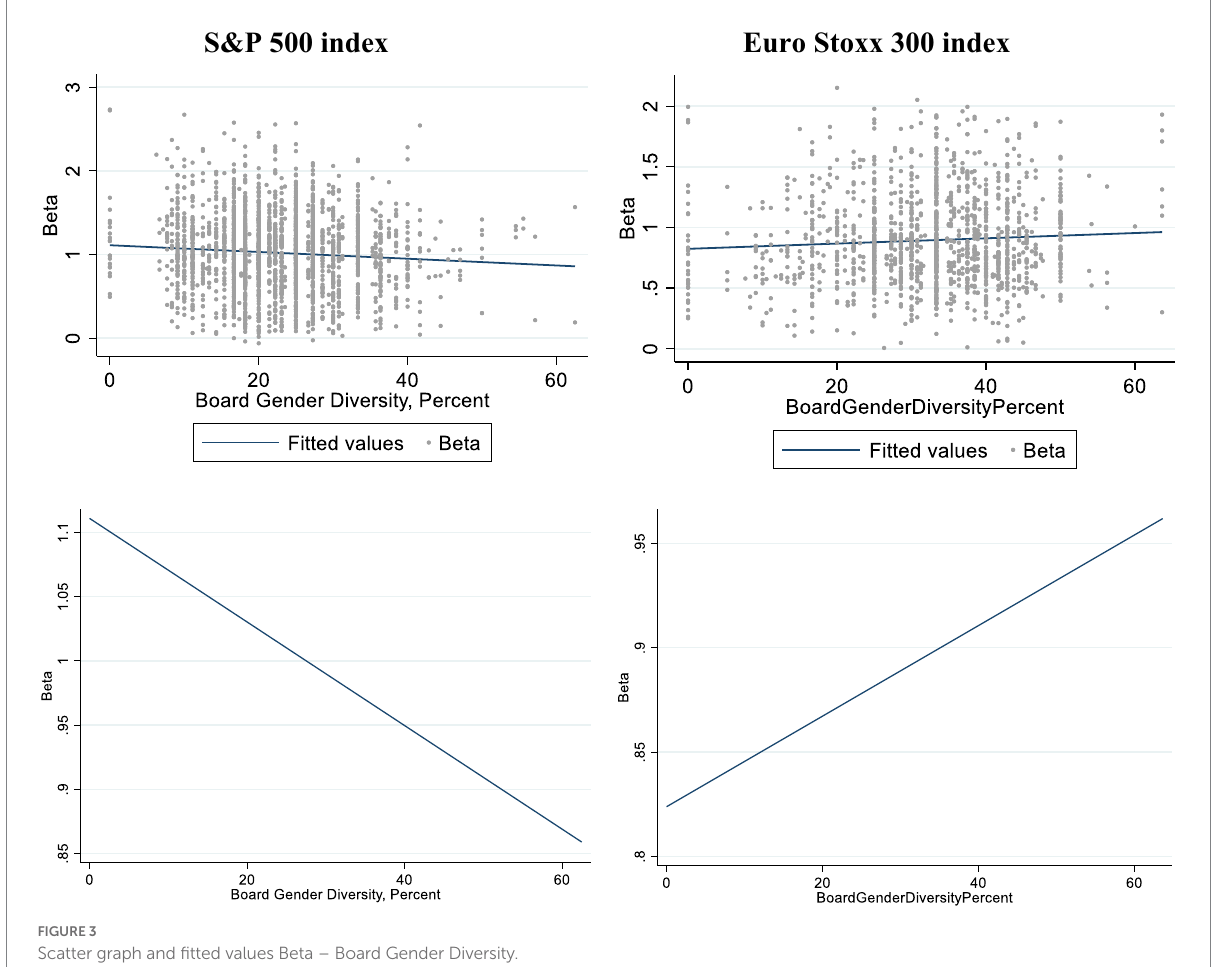
FIGURE 3 Scatter graph and fitted values Beta – Board Gender Diversity.